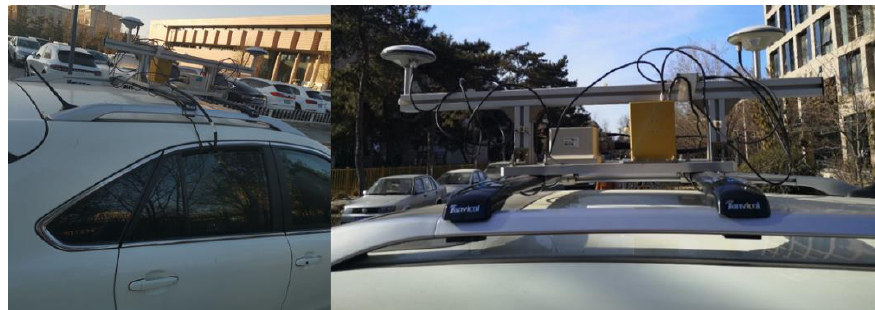
Figure 3. Experimental environments and setup.